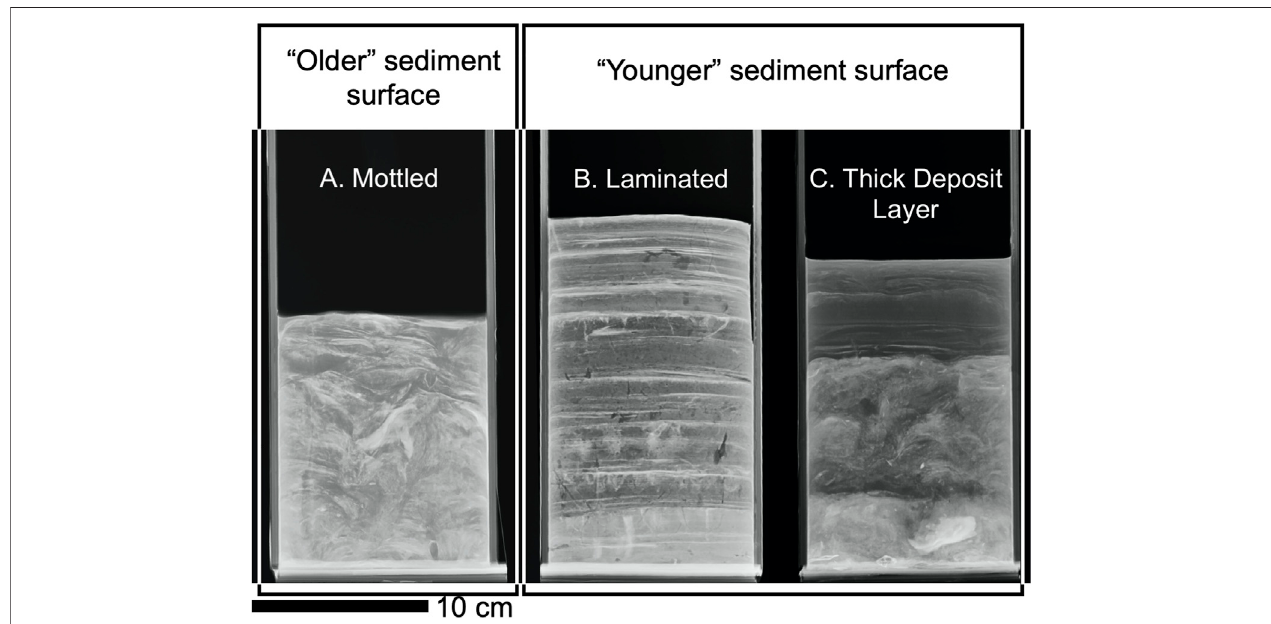
FIGURE 4 | X-ray images representing (A) mottled, (B) laminated, and (C) thick deposit layer fabrics. These “ negative ” images are darker where wet sediment density is lower. The laminated and deposit layer classes were combined and likely represent younger near-surface sediments, whereas the mottled class likely represents older near-surface